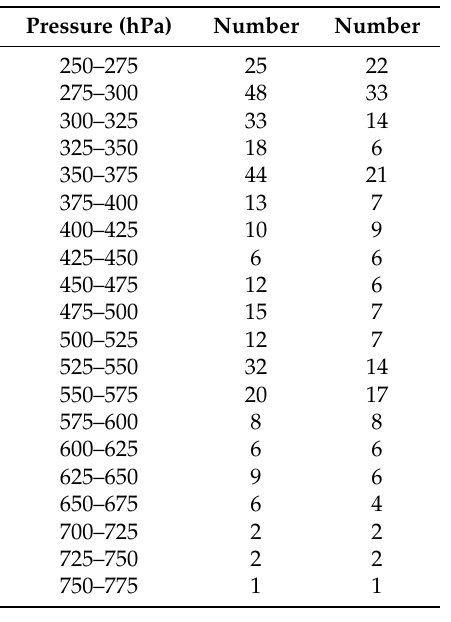
Table 1. Number of LWIR and SWIR pairs selected from channels at CO 2 bands of HIRAS within di ff erent pressure layers by original method (second column) and when adding the criterion based on the WF broadness in this study (third column) after step 1.